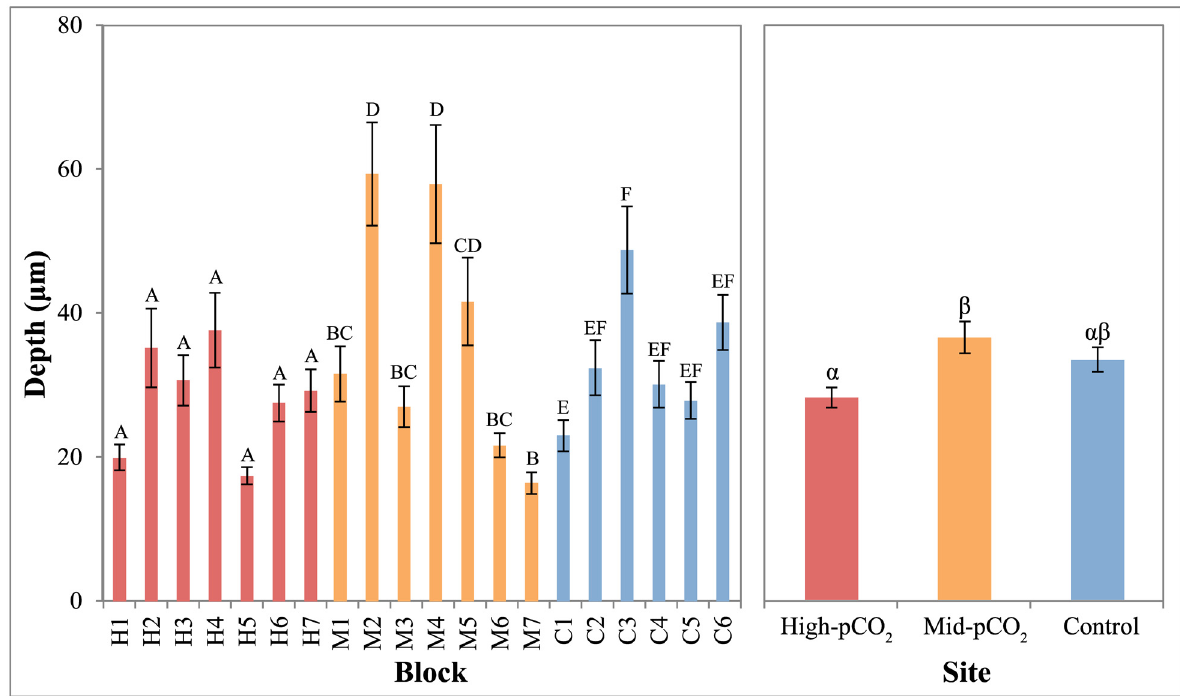
Fig 5. Mean depth of penetration of microboring filaments in each block and between sites. Blocks within sites or sites that share a letter (Roman or Greek, respectively) are not significantly different (P > 0.05). Error bars are standard error of the mean, calculated among individual measurements within each block (30 measurements per block, 6 – 7 blocks per site) and among all measurements within each site (180 – 210) in the left and right panels, respectively.